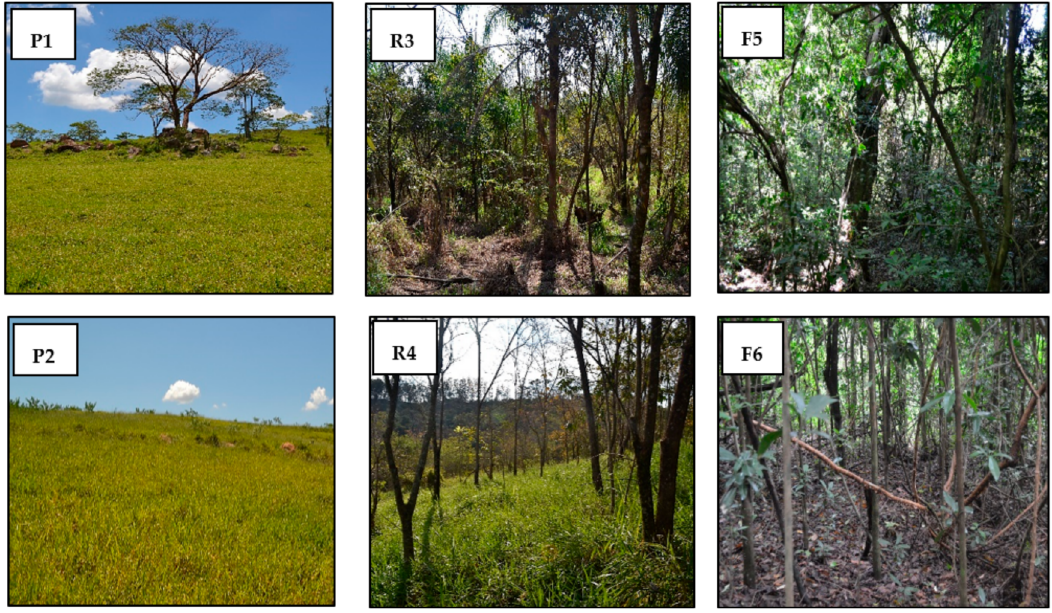
Figure 1. Pictures that represent the study sites in the seasonal semi-deciduous forest in Campinas, Brazil. Study sites are abbreviated with P1 and P2 for pasture, R3 and R4 for restored forest, and F5 and F6 for remnant